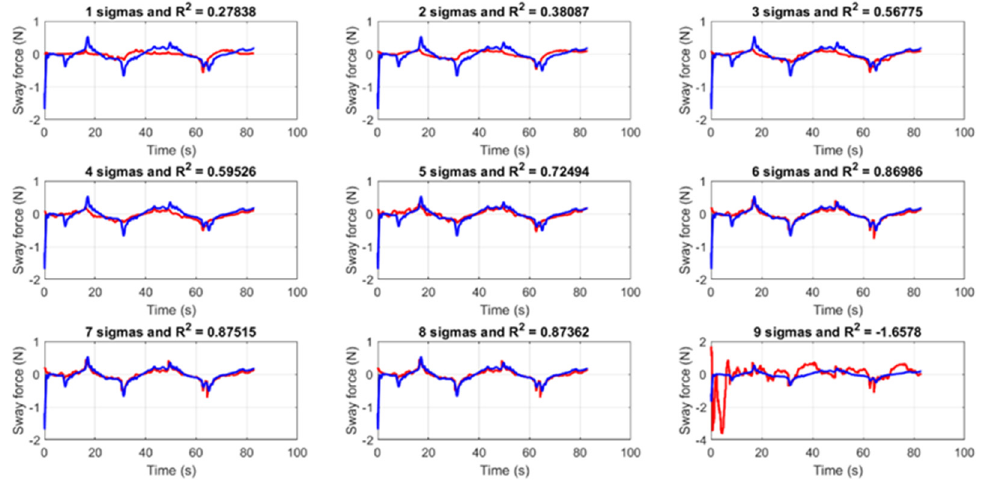
Figure 10. Measured (blue curves) vs. estimated sway force (red curves) for the tests’ data from the 30° − 30° zigzag manoeuvre.